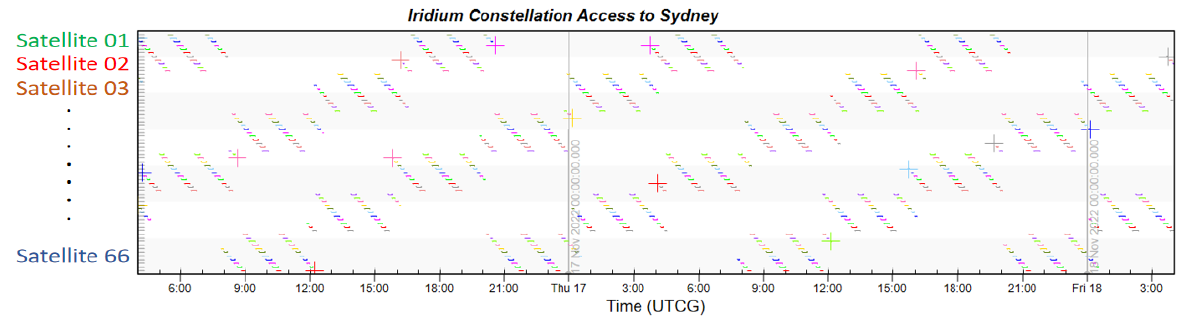
Figure 14. Iridium constellation access to Sydney.